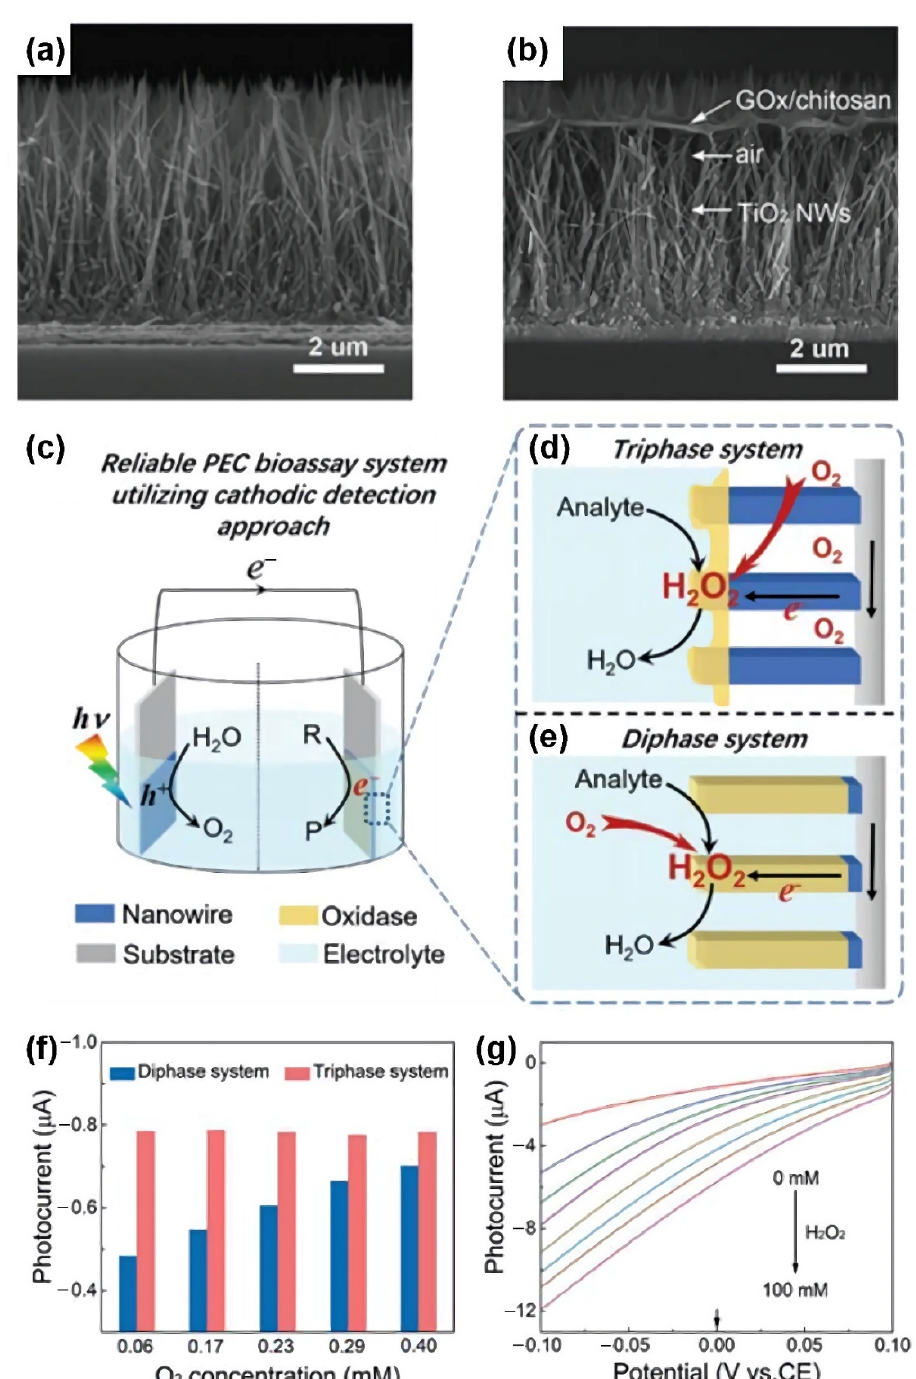
Figure 5. Schematic illustration of the morphology and composition of a photoelectrochemical (PEC) bioassay system and the advantages of the triphase system. ( a ) FE-SEM image of TiO 2 NWs fabricated on transparent the fluorine-doped tin oxide-coated glass substrate. ( b ) SEM image of the TiO 2 NWs surface that is covered by a graphene oxide (GO)/chitosan composite layer. ( c ) Schematic image of the reliable PEC bioassay system. ( d ) Enlarged image of the triphase bio-cathode reaction zone. ( e ) Enlarged image of the diphase bio-cathode reaction zone. ( f ) Triphase PEC system shows higher photocurrents than those of the diphase PEC system. ( g ) Linear sweep voltammograms of the PEC system while measuring H 2 O 2 . Reprint from [36]. Copyright (2018), with permission from WILEY-VCH, Weinheim,